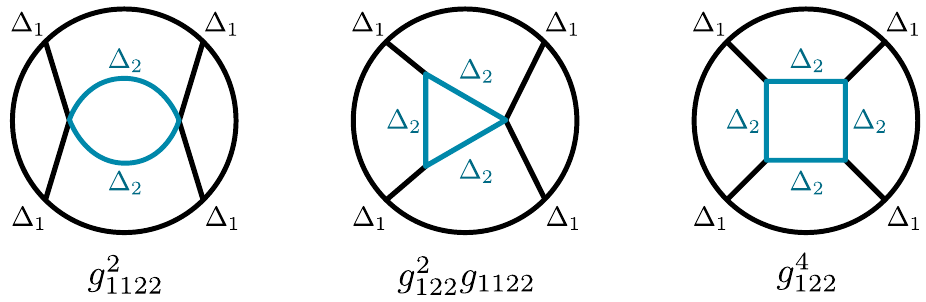
Figure 4 . Bubble, triangle and box Witten diagrams considered in the main